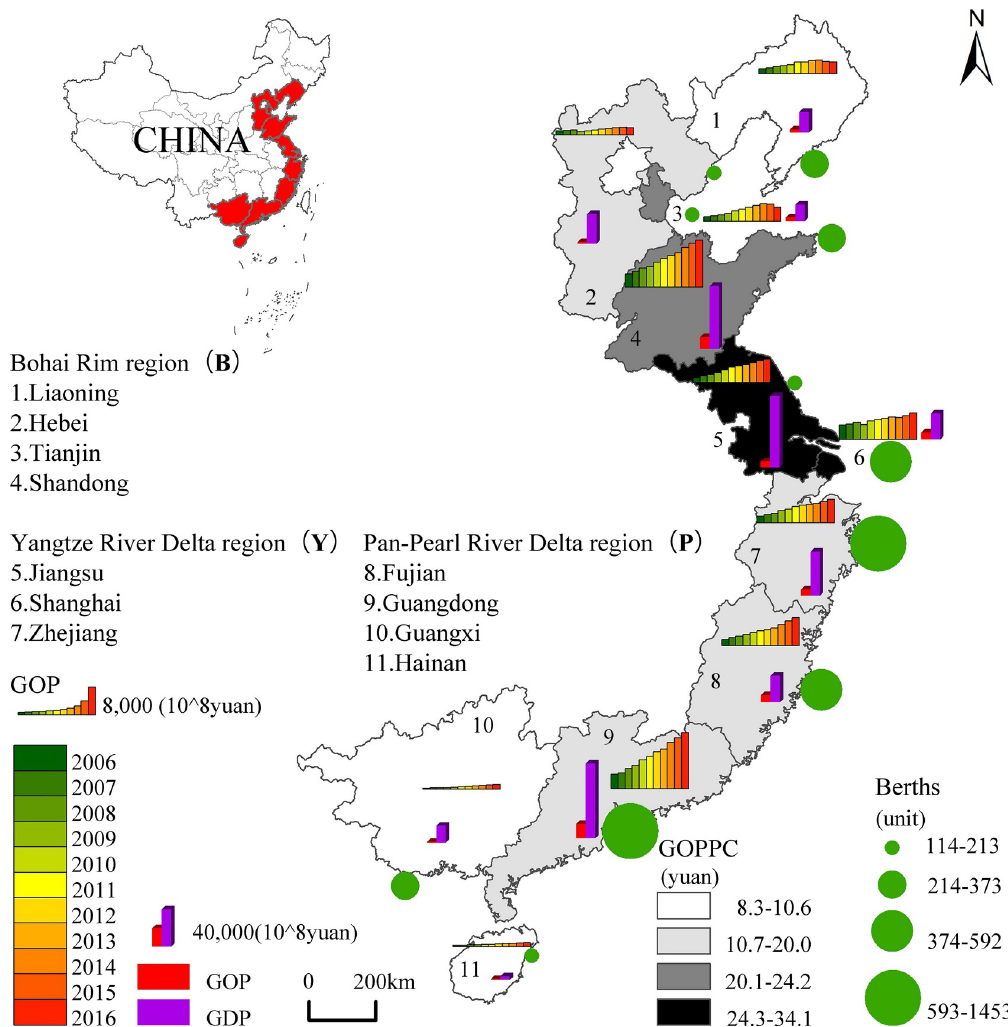
Fig 1. Development level of marine economy of China’s 11 coastal provinces and